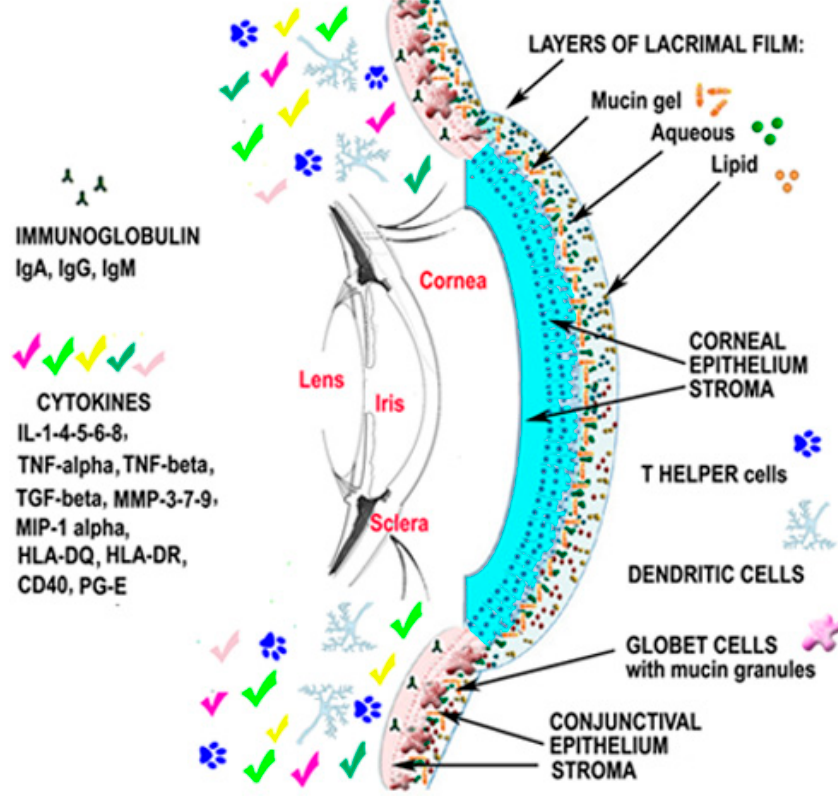
Figure 2. Dry eye results in the inflammatory response to diseases, infections, and damage of the ocular surface, and tear hyperosmolarity can activate a chain of events resulting in a vicious circle of inflammation of the anterior eye. Successively, the release of proinflammatory molecules secreted by several cells leads to the recruitment of immune cells as well as a disruption of the ocular surface. Interleukin-1-4-5-6-8 (IL-1-4-5-6-8); tumor necrosis factor- α (TNF- α ); tumor necrosis factor- β (TNF- β ); metalloproteases-3-7-9 (MMP-3-7-9); macrophage inflammatory proteins (MIP-1 α ); conjunctival human leukocyte antigen expression (HLA-DQ; HLA-DR); cell surface receptors (CD40 protein, CD40 ligand ICAM-1); prostaglandin-E (PG-E).